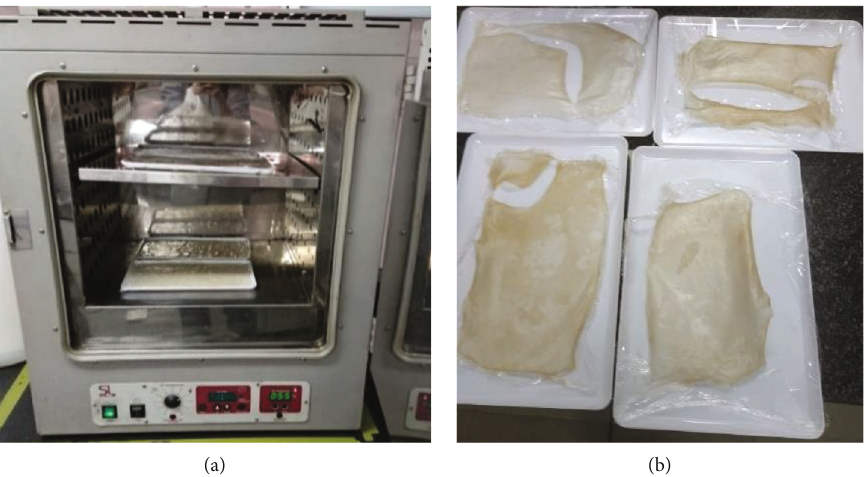
Figure 3: Drying stage. (a) Tray dryer with air circulation at a temperature of 55 ° C. (b) Dried bioplastic specimens.